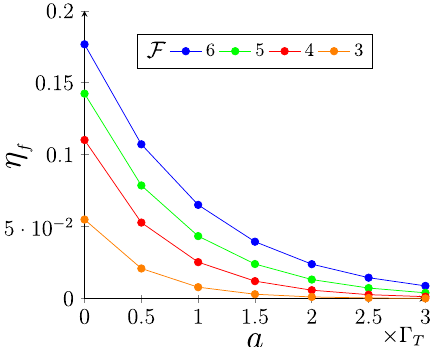
Figure 2. Here we have plotted the efficiencies as a function of the fluctuation strength a of the comb spacing 30 , tooth 2 Ŵ �/(γ and for various values of the finesse F T ) . We have chosen the optical depth α L = = + 10 K. From here we can see that although 5 MHz and the calculations are done at temperature T width γ = = the efficiency is decreasing as we increase the randomness, the efficiencies are significant even at fluctuations of the order of Doppler broadening Ŵ T